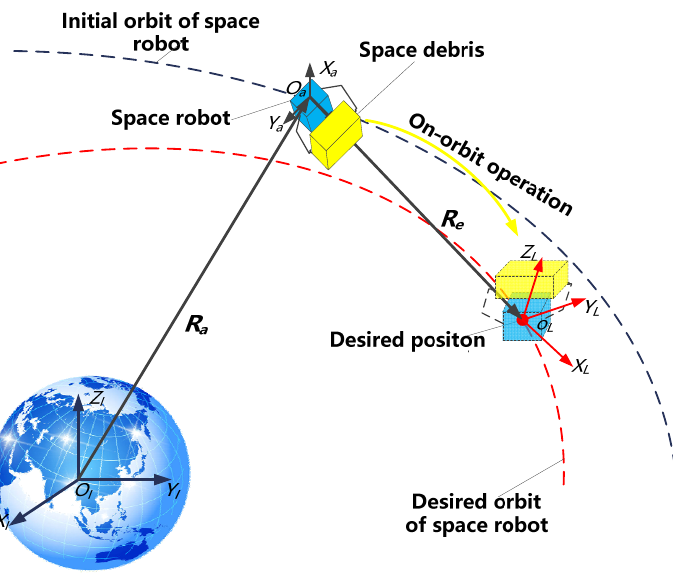
Figure 2. Configurations of the space robot.